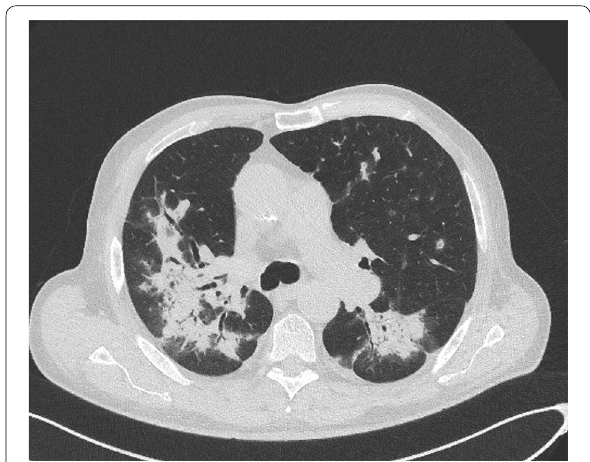
Fig. 5 Example of thoracic CT in immune‑related pneumonitis. The patient had been treated for NSCLC with pembrolizumab for 2 months. He developed acute respiratory failure. CT showed